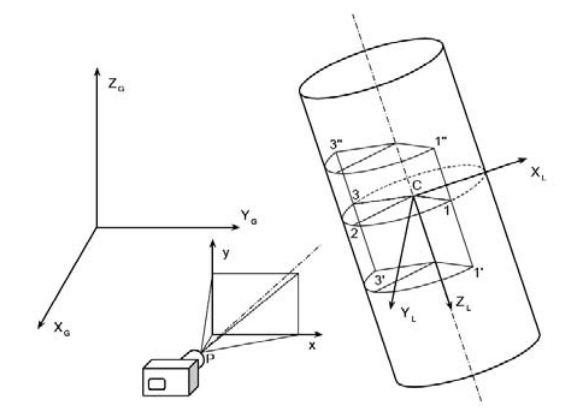
Figure 4. Coordinate systems and border of cylinder cuts Figure 6. Results after nearest neighbour and bicubic